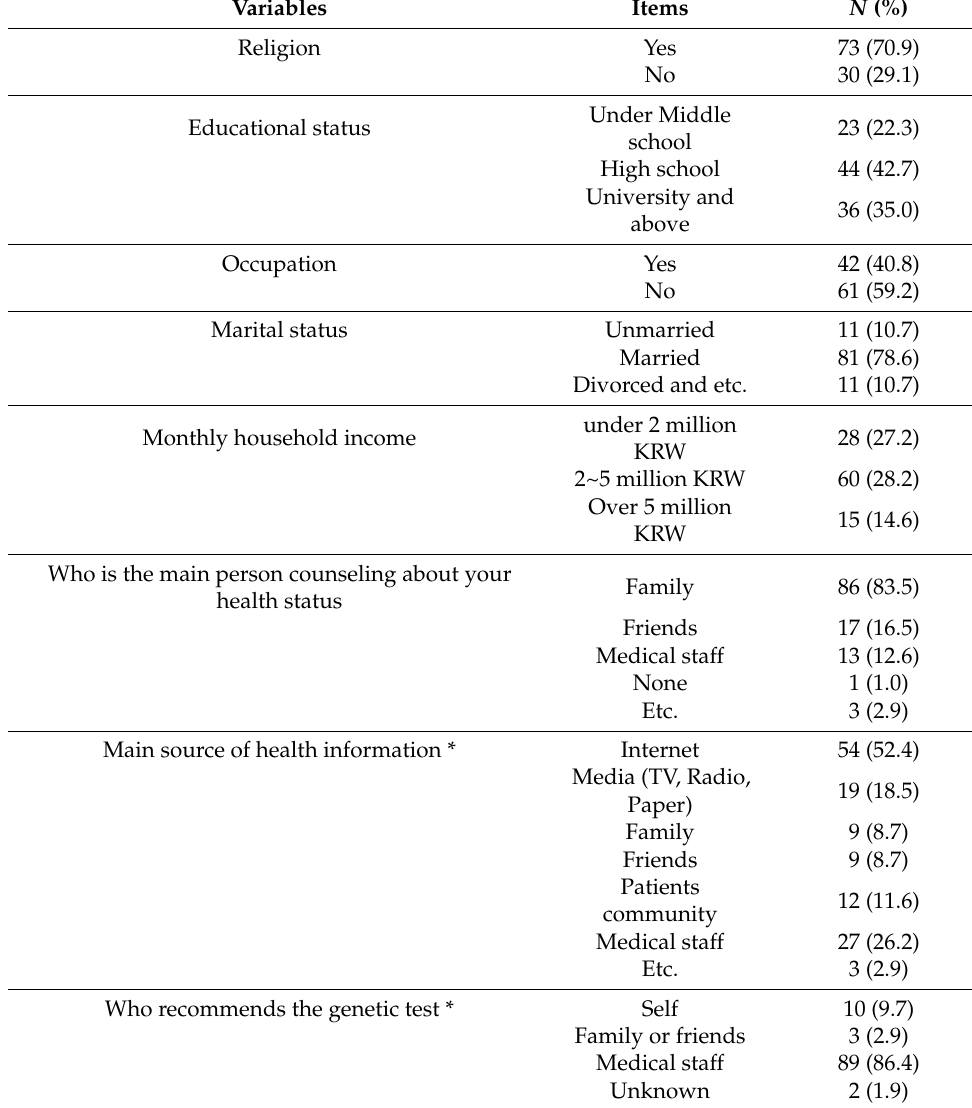
Table 2. Socio-demographic characteristics ( N = 103).